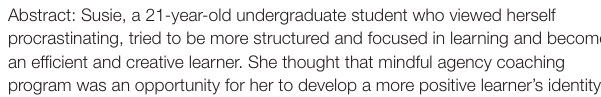
TABLE 2 | Narrative analysis of Susie’s